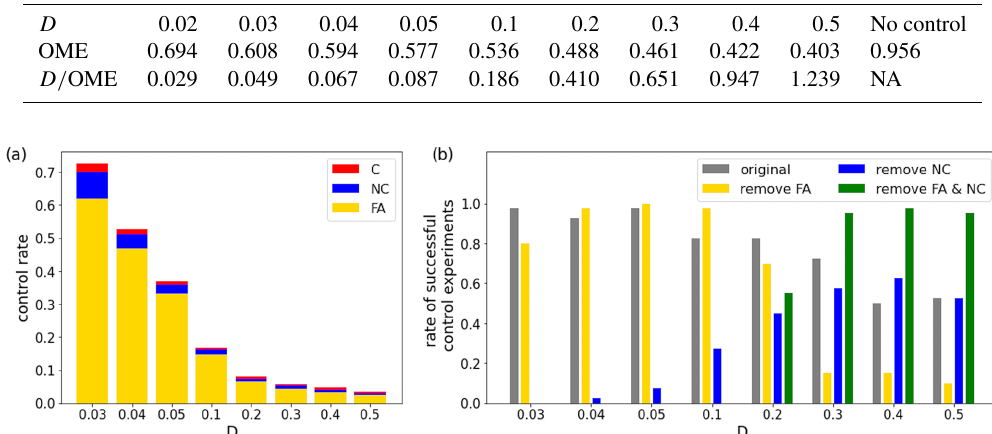
Table 1. Averaged one-step model evolution in the Euclidean norm (OME) and the relative size of perturbations ( D/ OME). Only successful control cases are considered for CSEs with T = (cid:100) 4 T 0 (cid:101) and perturbations added to variables x , y , and z . “NA” indicates not available.